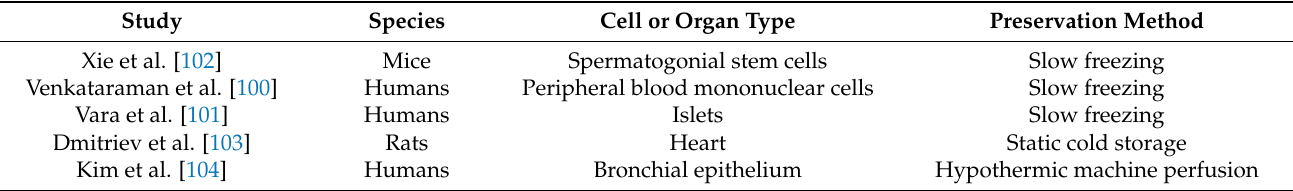
Table 2. Low temperatures trigger